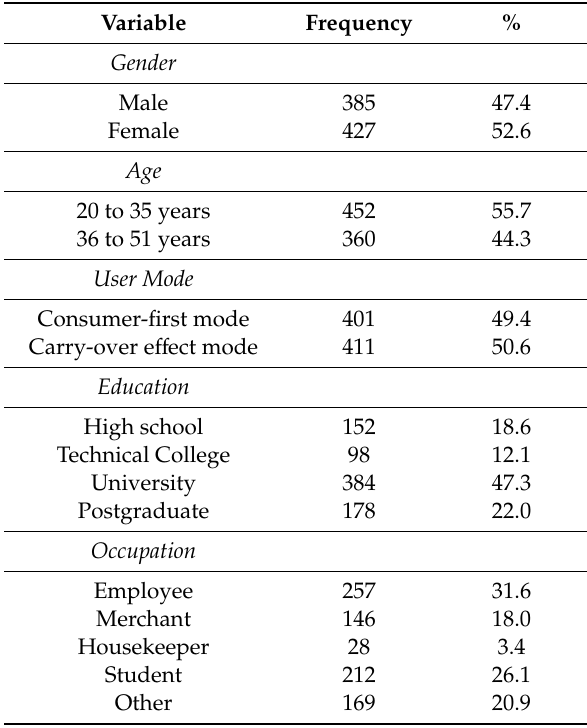
Table 2. Demographic features of the study sample.